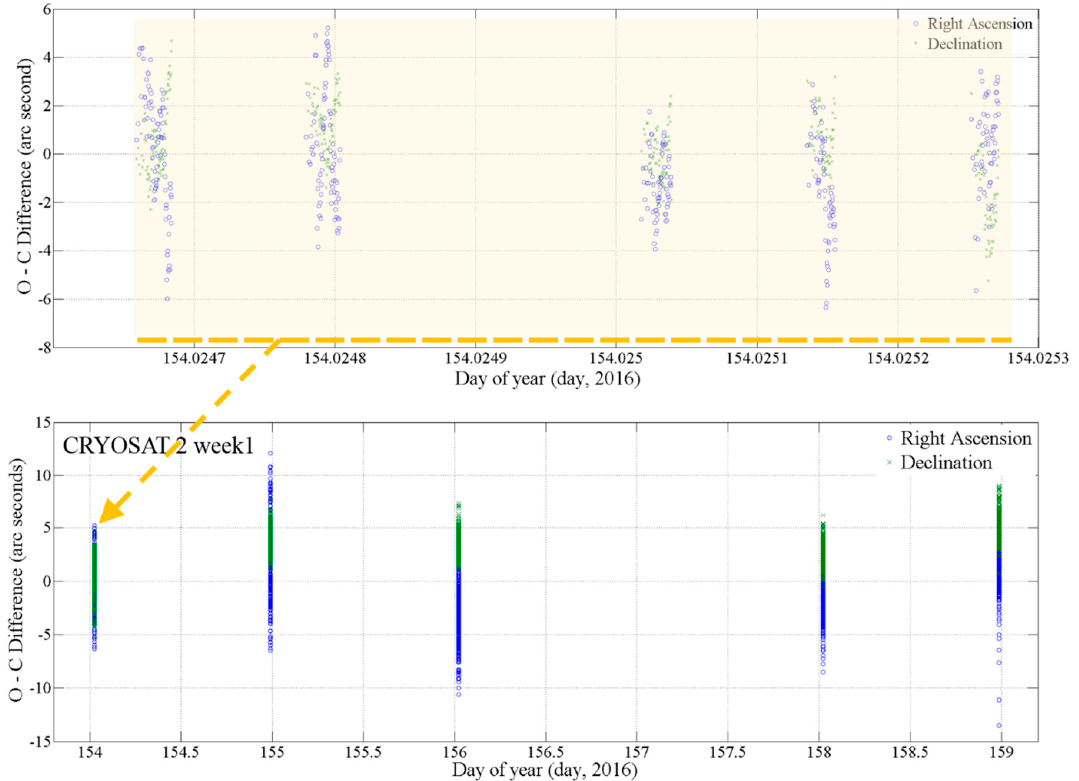
Figure 3. Residual observation-calculated (O-C) difference between the optical observation data from the OWL-Net and comparison Consolidated Prediction File (CPF) data for CRYOSAT 2 on 1 June 2016. The observation was performed by the OWL-Net at the Israel site. The upper graph shows the residual for 1 June 2016. There was one optical observation chance with five shots. The lower graph shows the residual from 1 June 2016 to 6 June 2016 for CRYOSAT 2.